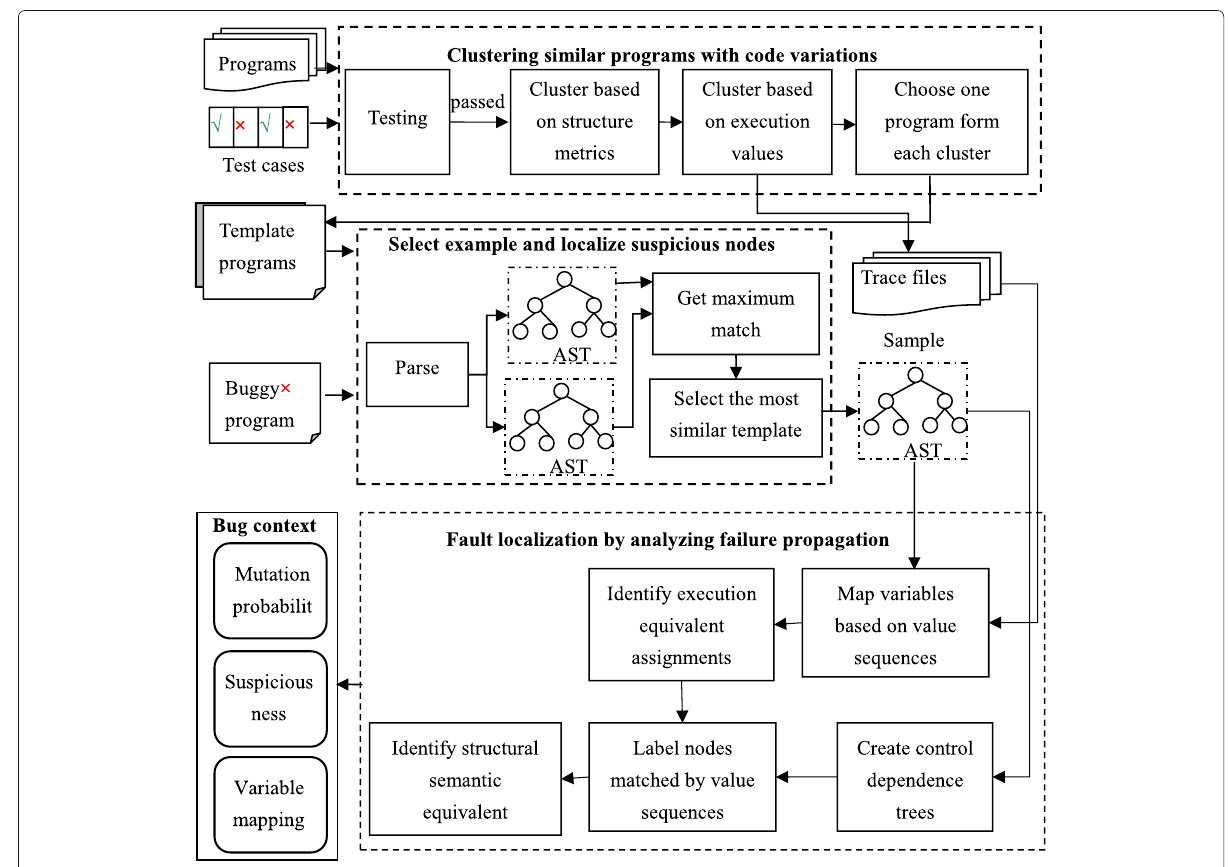
Fig. 2 Research framework of fault localization by analyzing failure propagation with samples